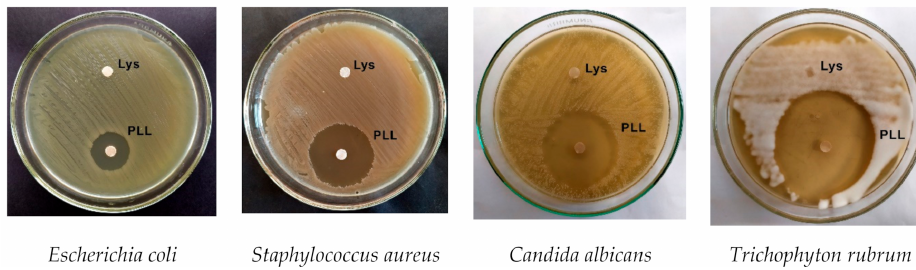
Figure 1. The antimicrobial efficacy of L-lysine ((Lys) (disk 1 mg/mL)) and poly-L-lysine ((PLL) (disk 1 mg/mL)) on microorganisms.